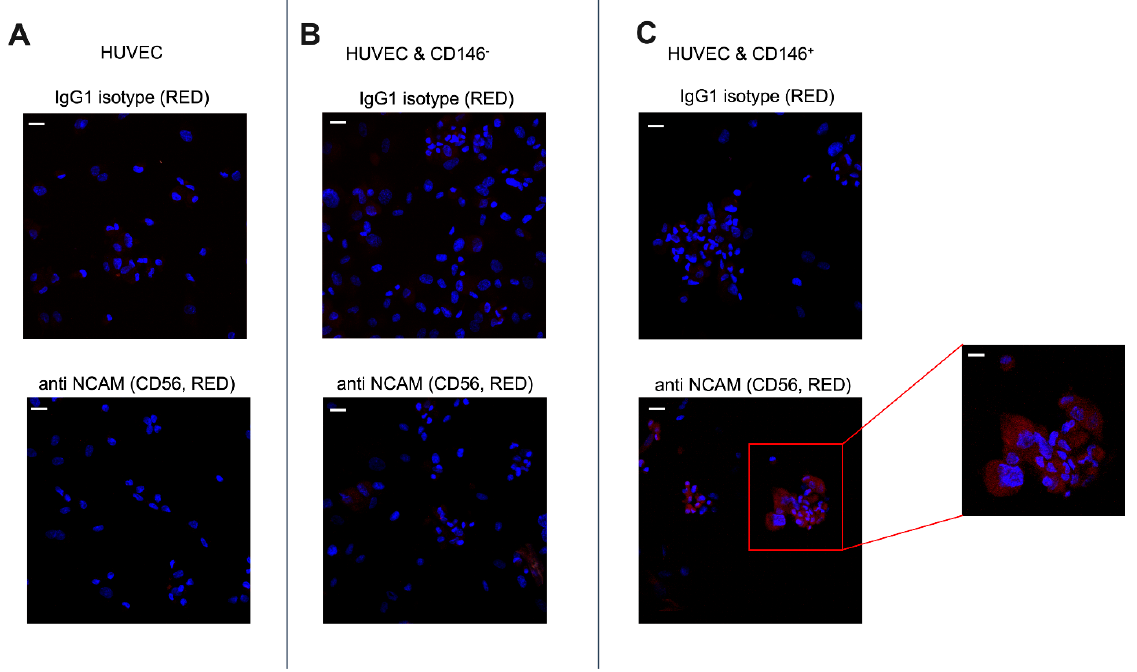
Figure 6. Differential expression of CD56 by CD146 − and CD146 + pericytes adhered to HUVECs. ( A ) The upper image represents HUVECs stained with an anti-IgG1 isotype. The bottom image represents the HUVECs monolayer stained with antibody to CD56 (NCAM) as a negative control. ( B , C ) PCs detached from culture flasks were seeded on the cultured ECs monolayer. The two different morphologies in the figure represent adherent PCs as round cells adjacent to relatively long ‐ shaped HUVECs. The upper images represent ECs ‐ PCs co ‐ culture stained with the negative control IgG1 isotype. The bottom images represent ECs ‐ PCs co ‐ culture stained with CD56 (NCAM). Images are representative of two different experiments performed in triplicates; magnification, 40×. Scale bar = 25 μ M. The extreme right image displays the higher magnification image; magnification, 100×. Scale bar = 10 μ M. Images display pericytes in red, adhered to HUVECs, and nuclei in blue.